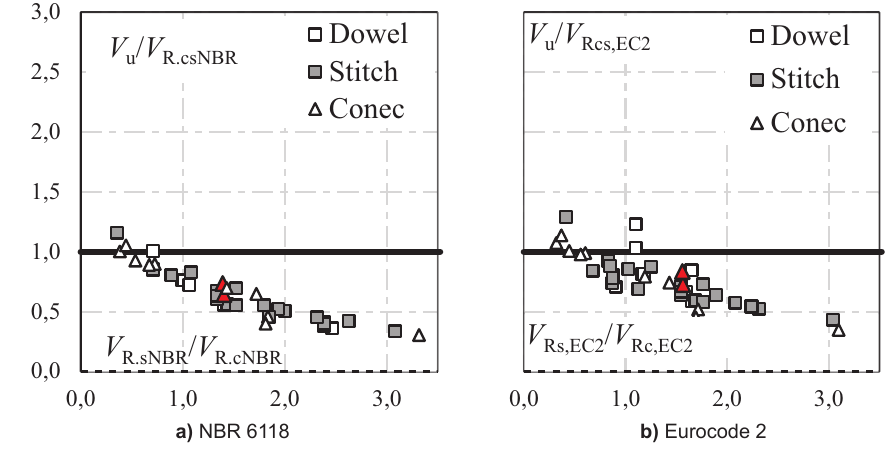
Figura 14 Desempenho das previsões de resistência dentro da região reforçada (ignorando-se as limitações propostas na Tabela